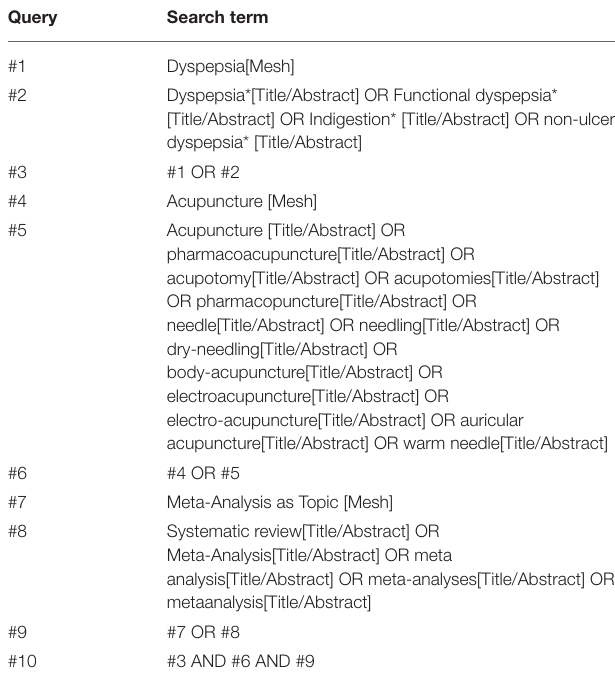
TABLE 1 | Detailed retrieval strategy for